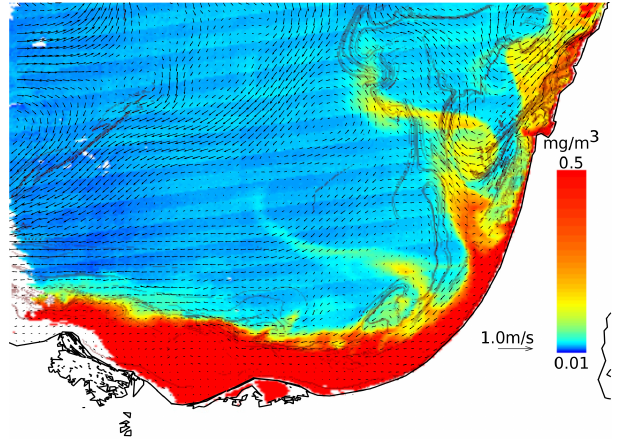
Fig. 21. Satellite image of chlorophyll (29 April 2013) show- ing filaments protruding from the coast at the southeastern Lev- antine Basin. Superimposed on the image are the currents and the Lagrangian analysis of passive tracer circulation. The satel- lite image was obtained from the MyOcean project and the cur- rents and Lagrangian analysis from Israel’s Marine Data Center